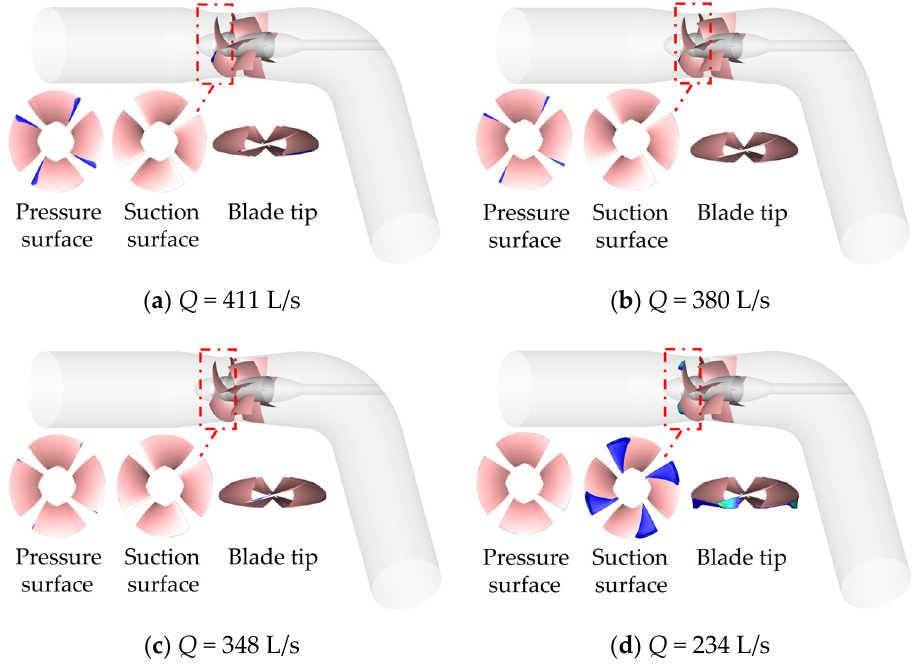
Figure 9. Air bubble distribution volume cloud diagrams at p in = 11 × 10 4 Pa.